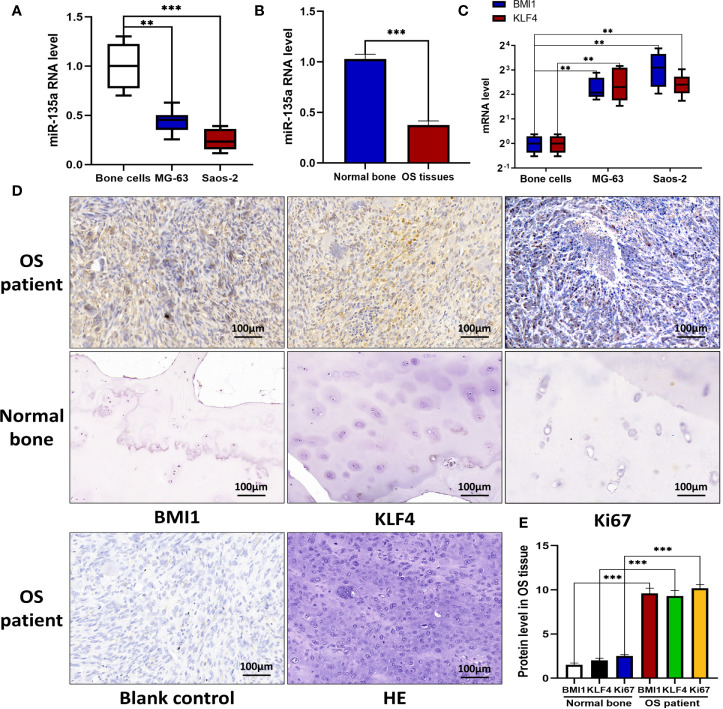
Downregulation of miR-135a and upregulation of BMI1 and KLF4 in OS cell lines and tissues. (A) RT-qPCR. OS cell lines Saos-2 and MG-63, and primary normal bone cells (osteoblasts) were grown and then subjected to RT-qPCR analysis. The results showed that endogenous miR-135a expression was decreased in Saos-2 and MG63 cells when compared to osteoblasts (**p < 0.01; ***p < 0.001; n=3). (B) RT-qPCR. Levels of endogenous miR-135a expression was decreased in OS tissues when compared to normal bone (***p < 0.001; n=3). (C) RT-qPCR. Levels of BMI1 and KLF4 mRNA were higher in Saos-2 and MG63 cell lines compared with osteoblasts (**p < 0.01; n=3). (D) Immunohistochemistry. Human OS and normal bone tissues were collected and subjected to immunohistochemical analysis. Scale bar, 100 μm. (E) The graph represents quantified data of the immunohistochemistry (***p < 0.001; n = 10). All the data from qPCR were expressed as the mean ± SEM.